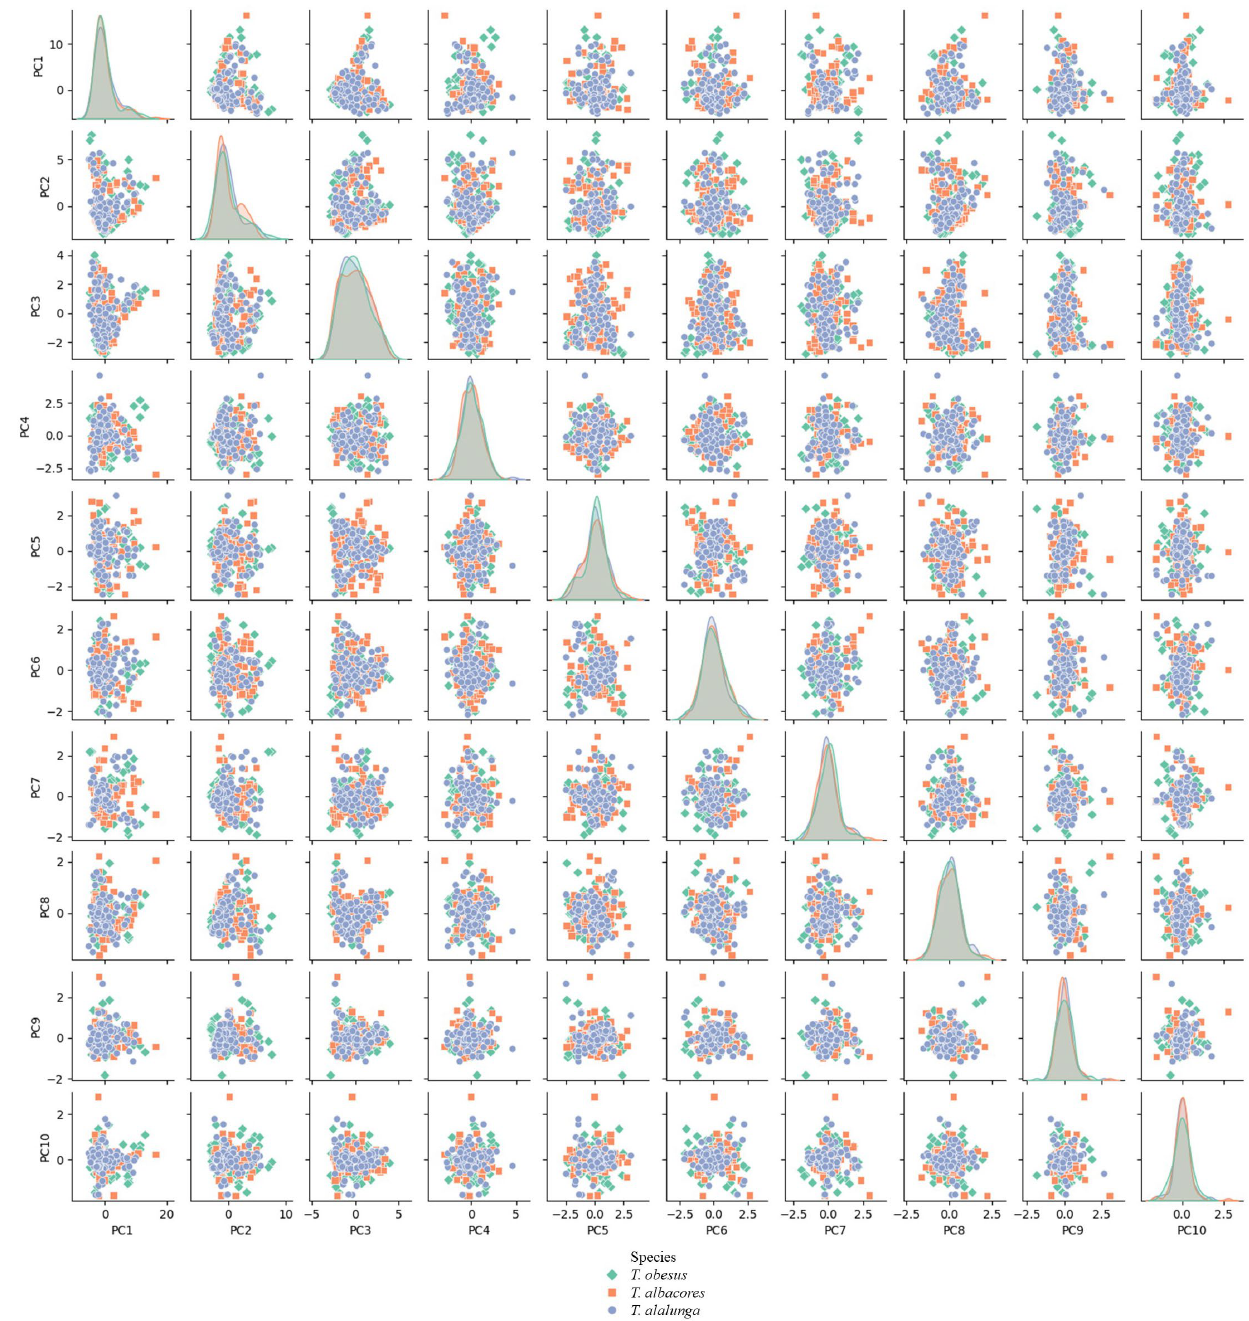
Figure 6. Principal component analysis of deep features: the principal component had 100 tuna for each